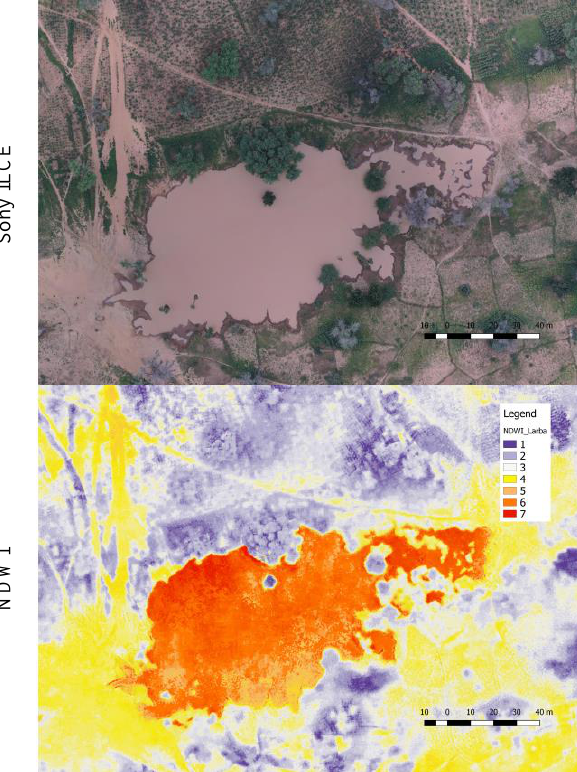
Figure 8. Example of temporary surface water bodies from the village of Larba Birno. Above: the Sony ILCE RGB information at 3 cm of resolution. Below: the NDWI data, which derives from the NoIR camera acquisition the resolution is